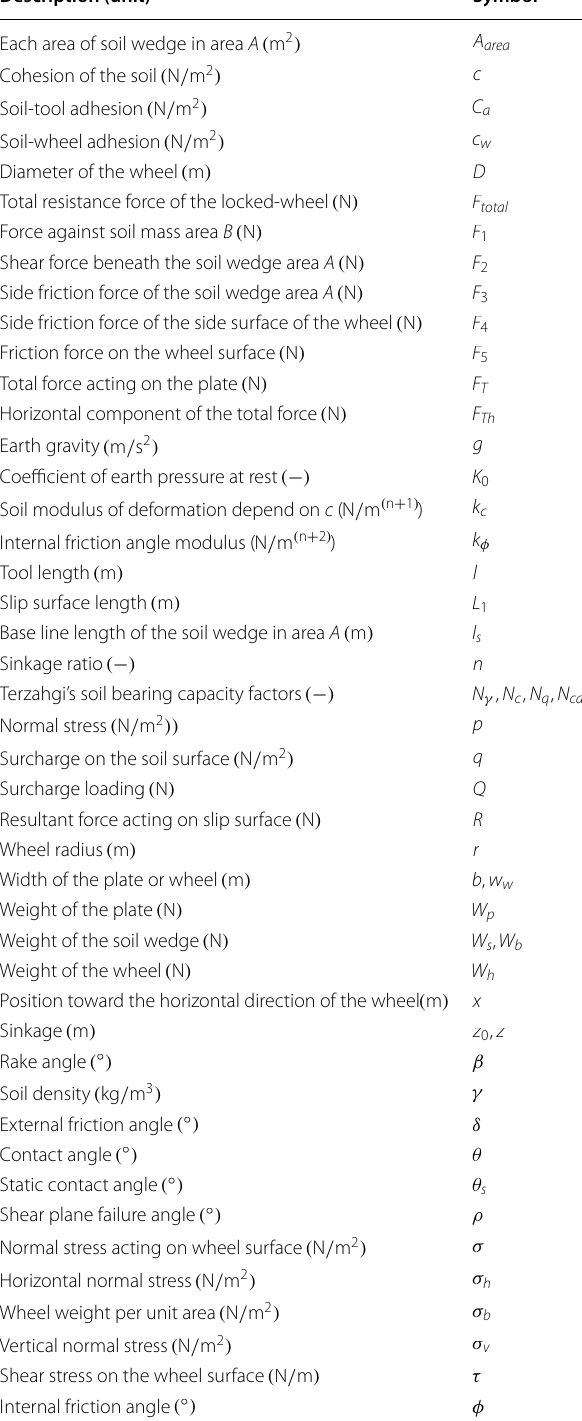
Table 1 List of